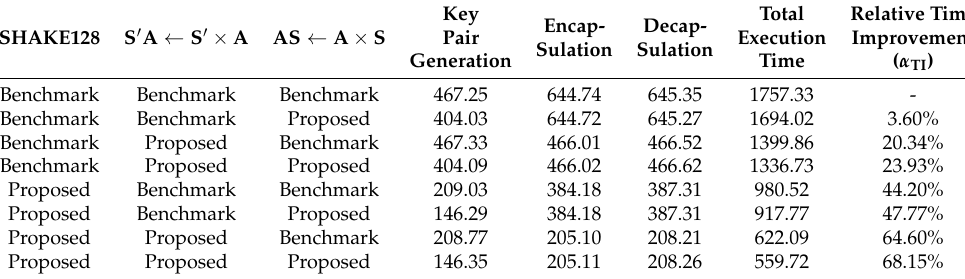
Table 3. The execution time for different levels of hardware implementations, in milliseconds